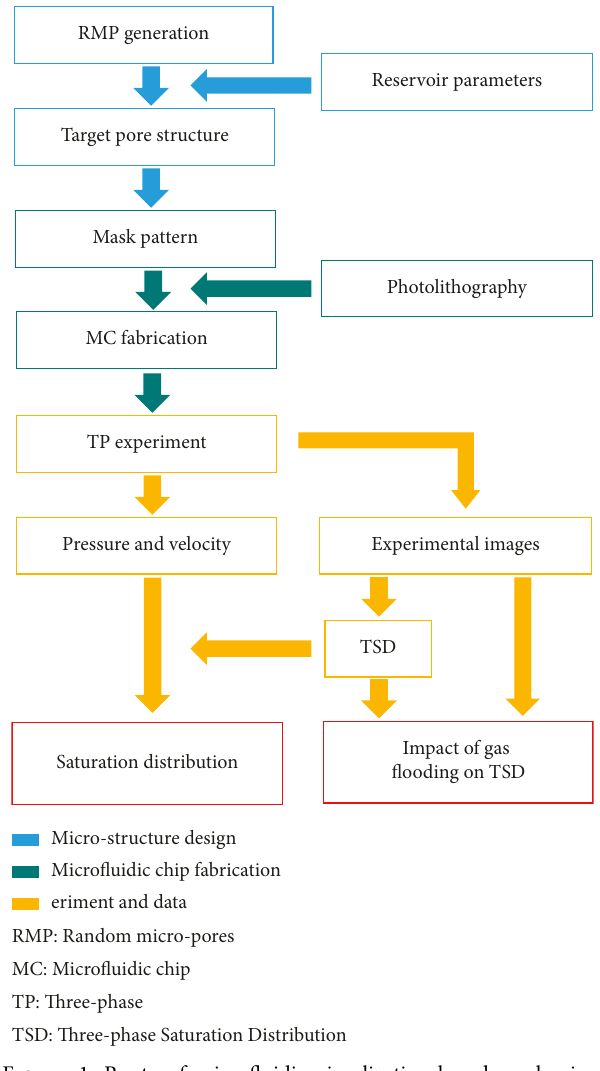
Figure 1: Route of microfluidic visualization-based mechanism and optimization research on TSD by gas